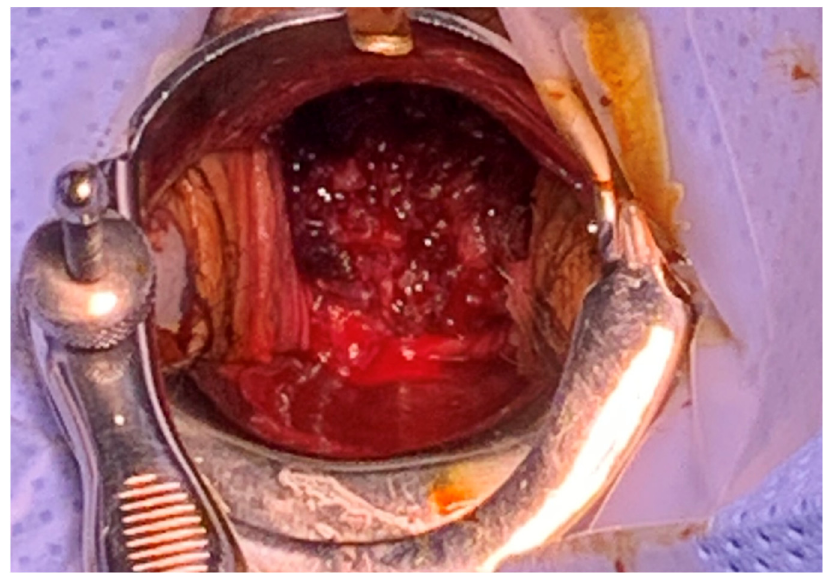
Figure 1. Initial vaginal examination. A solid mass-like lesion was visible along with active